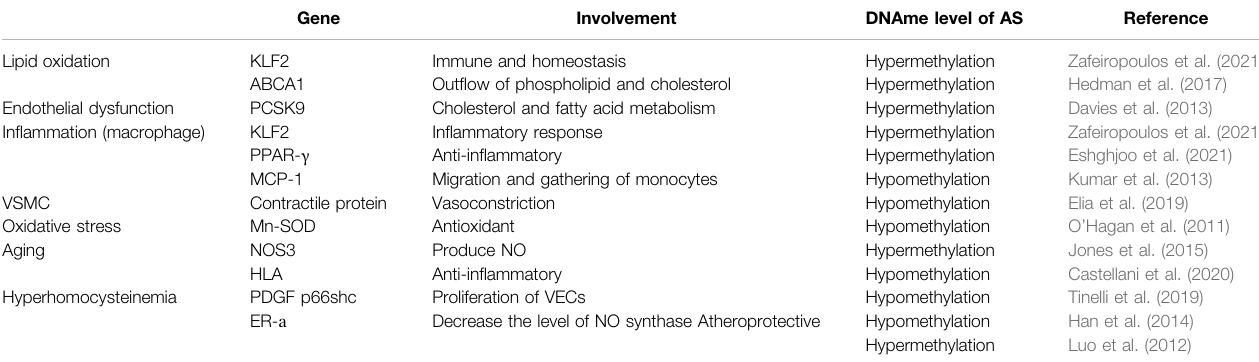
TABLE 2 | Atherosclerosis-speci fi c genes modulated via DNA methylation during the